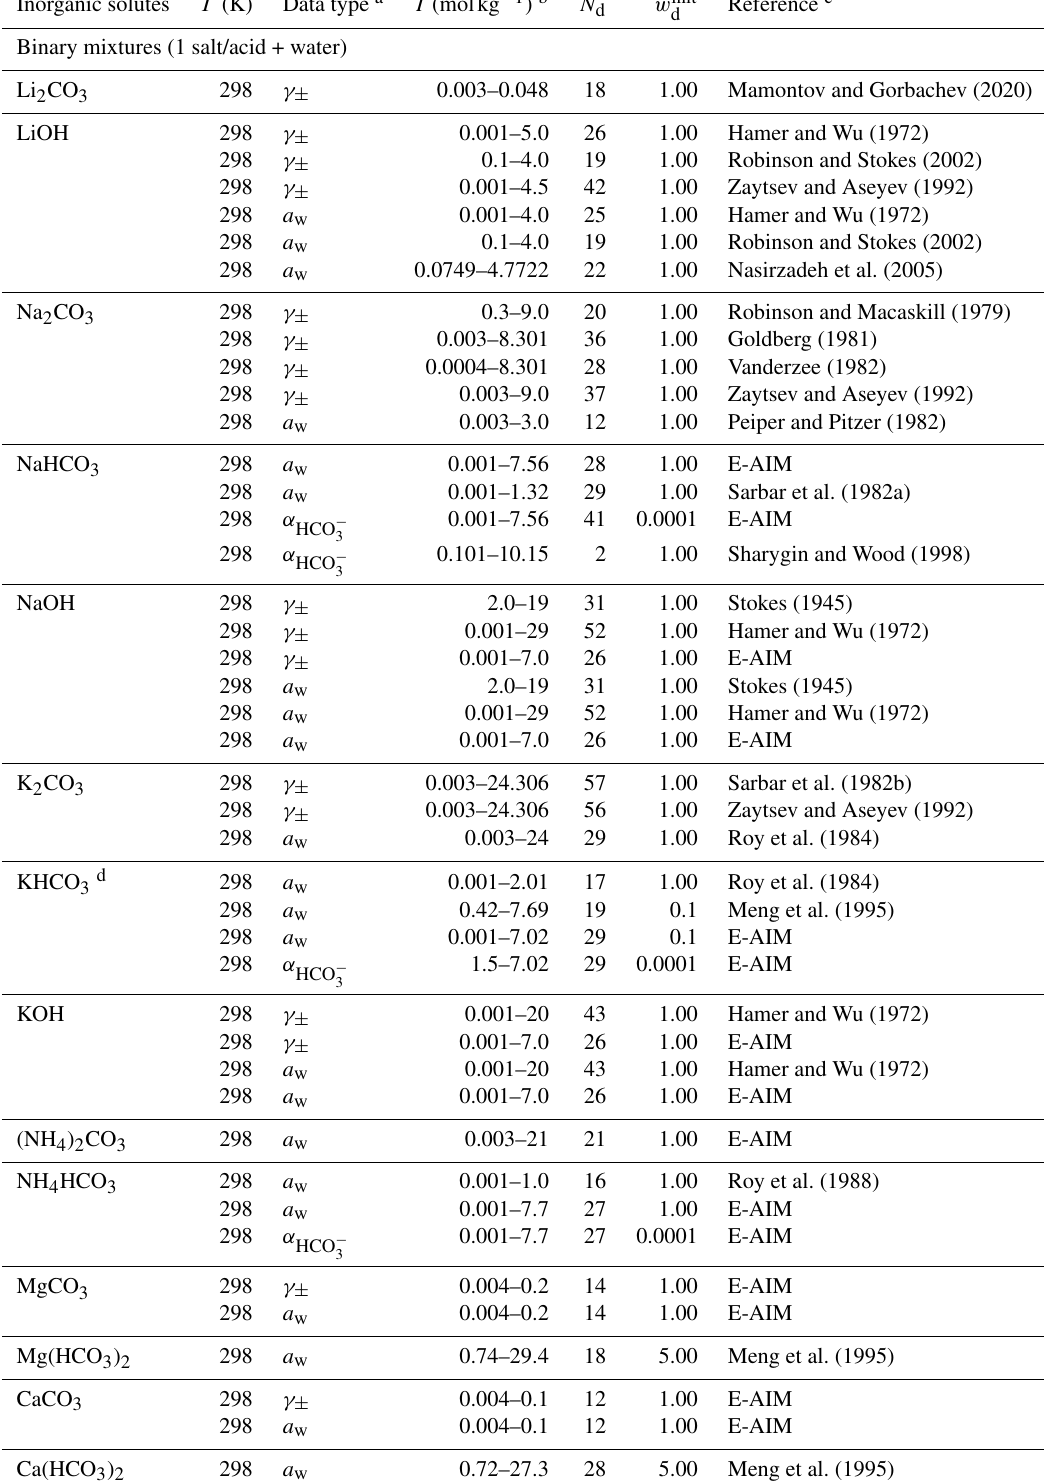
Table 6. Experiment temperature ( T ), data type, molal ionic strength ( I ) range, number of data points ( N d ), initial weightings ( w d ), and references used to fit the MR interaction parameters for cation–anion pairs in the carbonate system. Inorganic